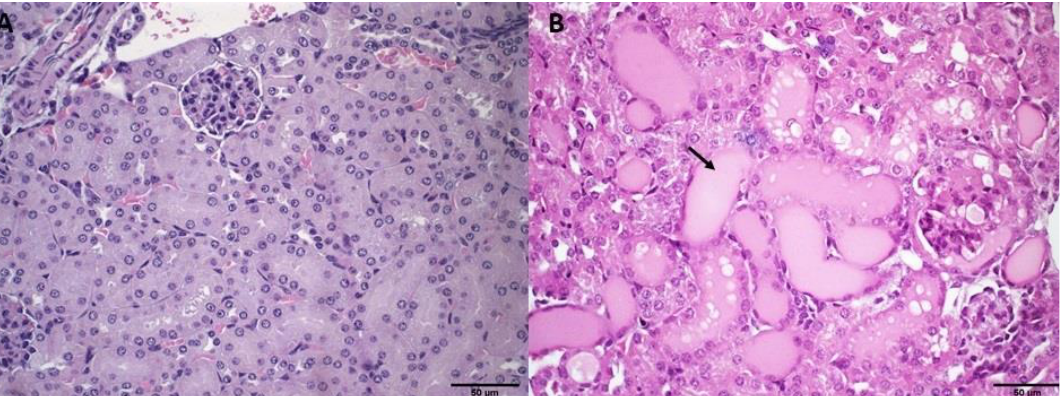
Figure 2. Histological sections of female Balb/c mice kidney. ( A ) Represents the control group (HBS) and the groups treated with both doses of ExoSpHL-DOX (15 and 17.5 mg/kg) and SpHL-DOX at a dose of 15 mg/kg. ( B ) Represents the groups treated with both tested doses of free DOX (10 and 12.5 mg/kg) and SpHL-DOX at a dose of 17.5 mg/kg. The arrow indicates the regions of tubule dilation. HE, scale bar = 50 µm.